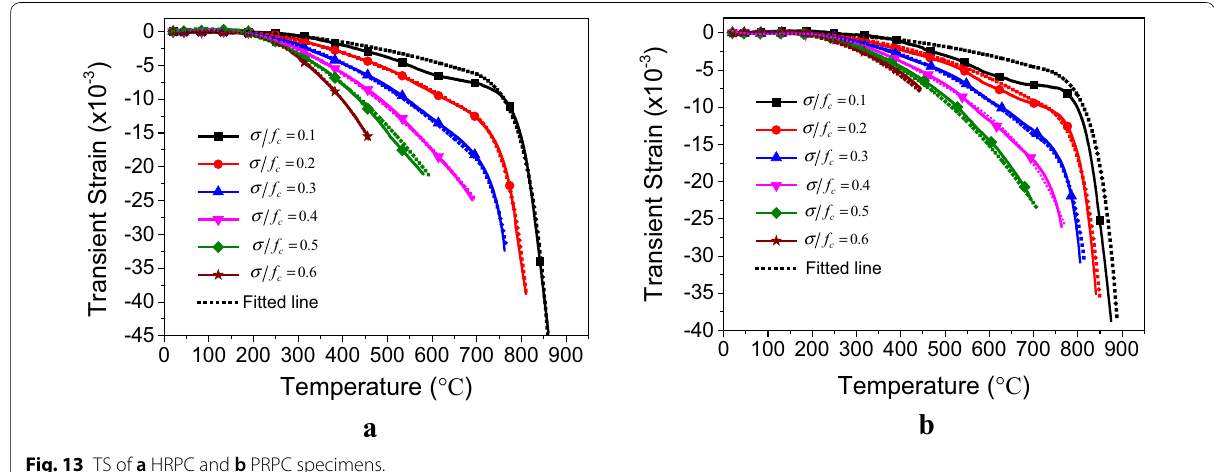
Fig. 13 TS of a HRPC and b PRPC